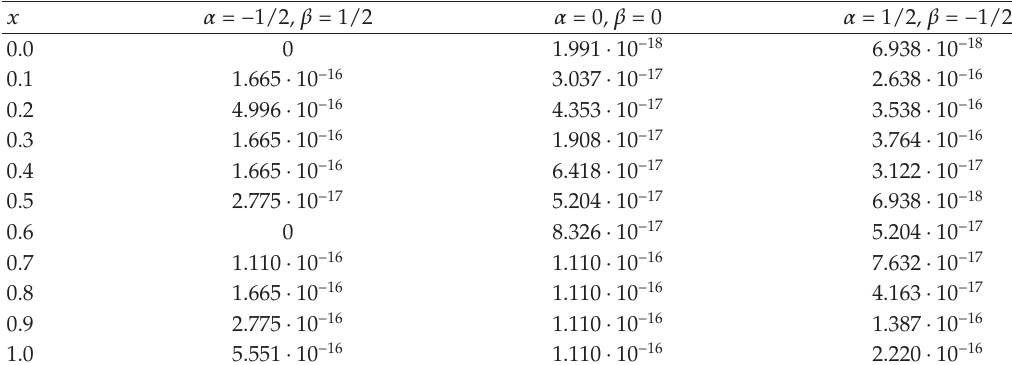
Table 6: Absolute error using SJC method for N (cid:9) 18 Example